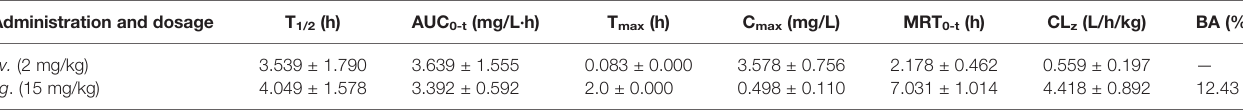
TABLE 3 | Pharmacokinetic parameters of Eth in Sprague-Dawley rats. Administration and